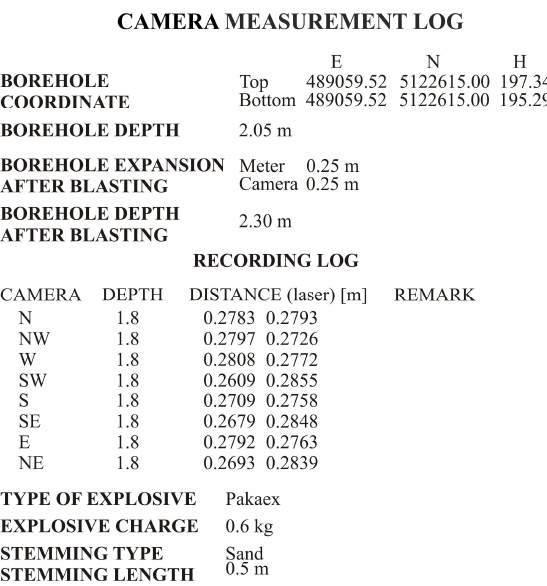
Figure 6. Separate layers belong to specific boreholes [4]. The dotted diagram can be triggered from the action “3D model (dotted)“. This model shows a 3D preview of the borehole (Figure 7a) or the resulting expansion (Figure